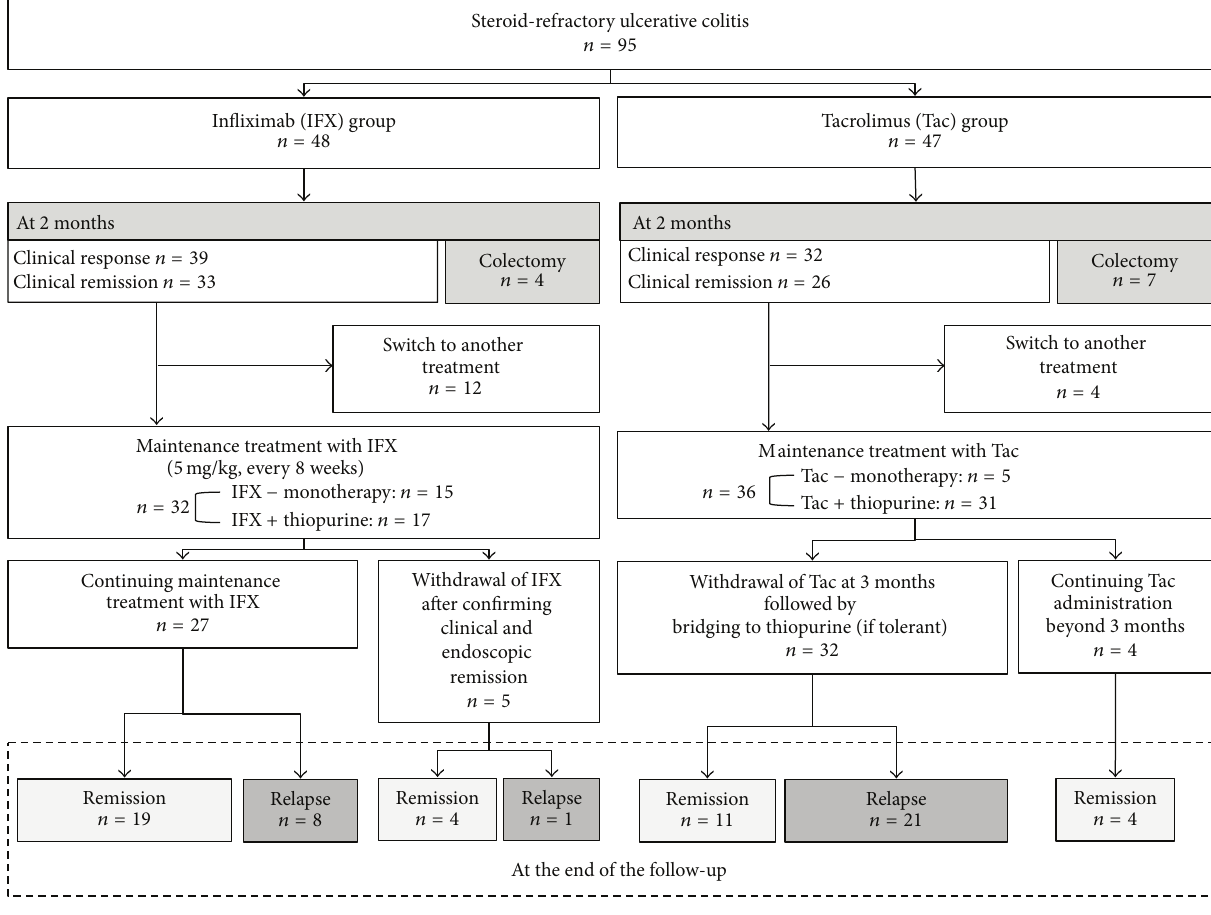
the two groups, except for disease duration. The proportion of thiopurine-na¨ıve patients at treatment onset was higher in the Tac group than in the IFX group (79% versus 46%, 𝑝 = 0.0004 ). In the IFX group, 14 out of 48 patients